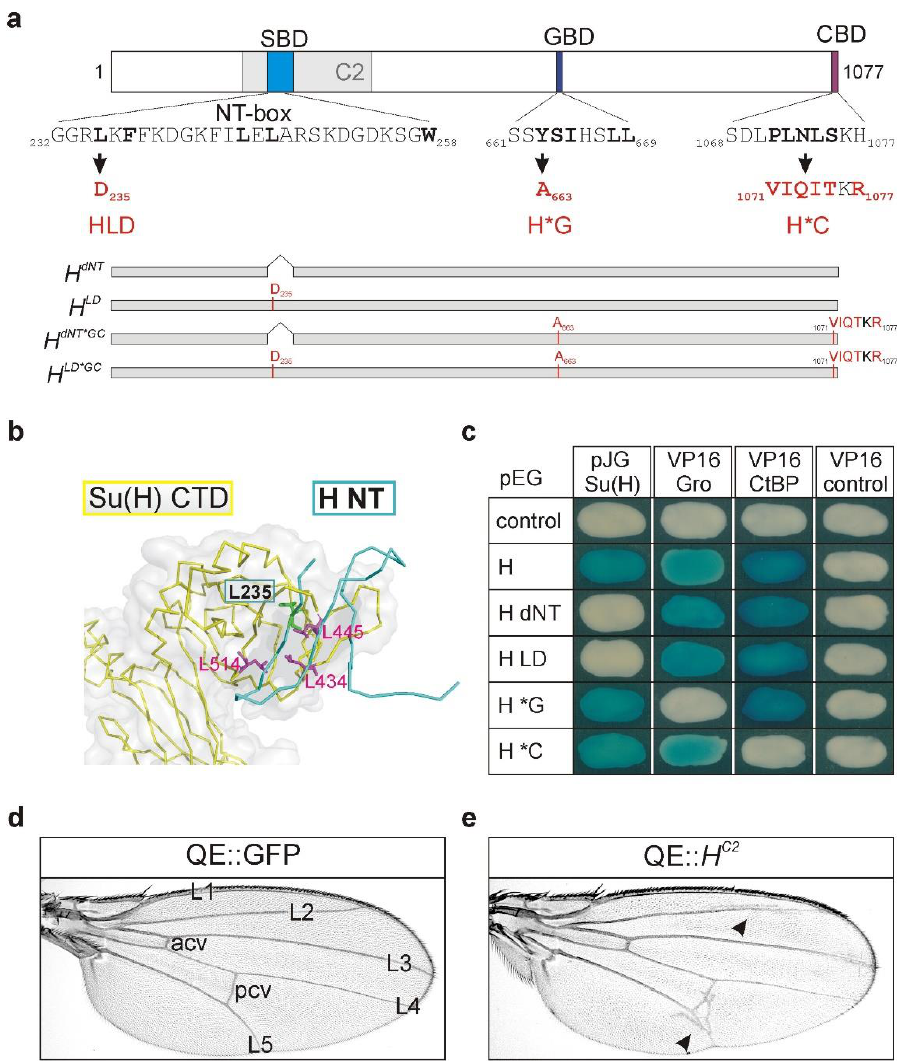
Figure 1. Hairless mutants affecting Su(H) and co-repressor binding. ( a ) Scheme of the H protein with the Su(H)-binding domain (SBD, cyan), the Gro-binding domain (GBD, blue), and the CtBP-binding domain (CBD, purple) indicated. Numbering is according to [55]. The C2 deletion is shown in grey.